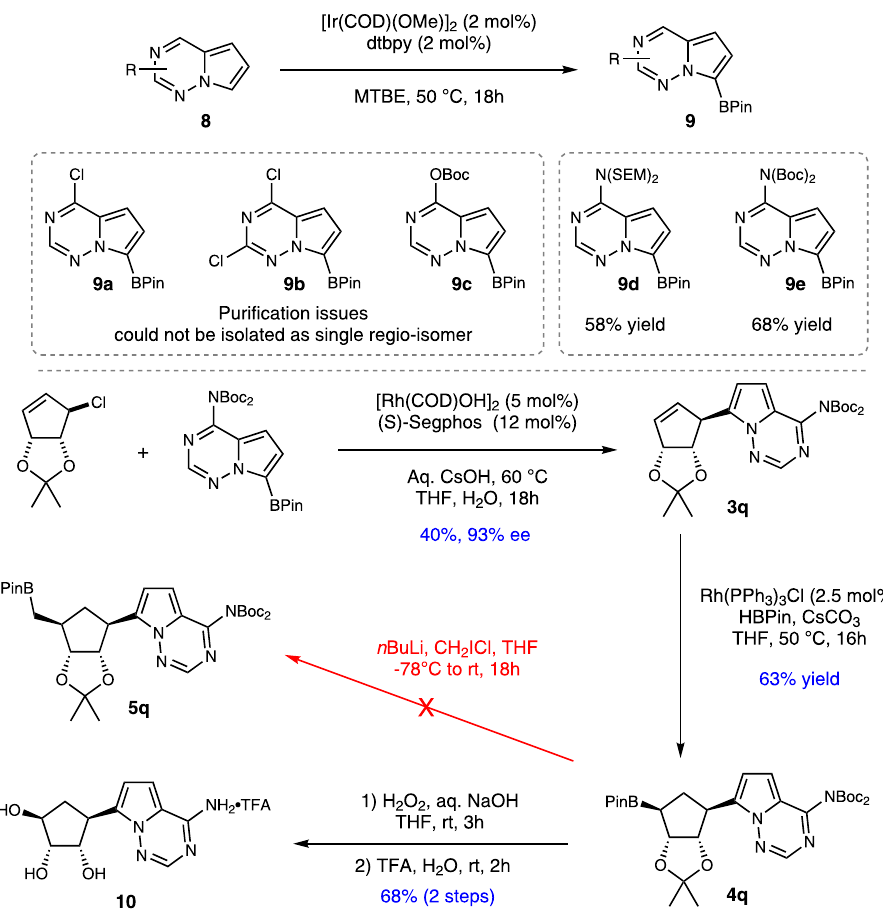
Fig. 7 Attempts toward complex CC-Ns. Cross-coupling attempts with pyrrolo-trazine boronic acids.